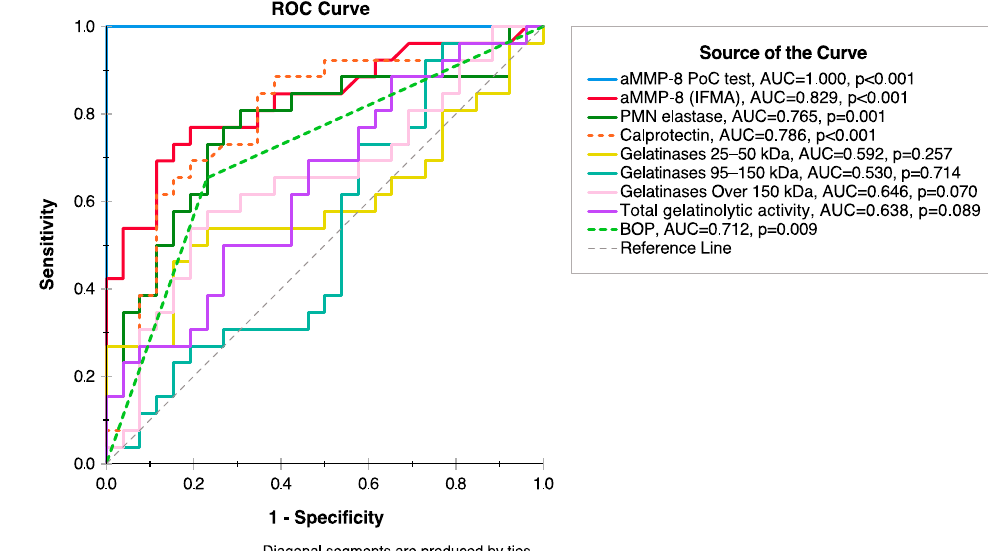
Figure 1. Receiver operating characteristic (ROC) analysis illustrating the diagnostic ability of active matrix metalloproteinase-8 (aMMP-8) chair-side / point-of-care (PoC) test and selected potential biomarkers: polymorphonuclear leukocyte (PMN) / neutrophil elastase, calprotectin, gelatinases (25–50 kDa, 95–150 kDa, over 150 kDa and total gelatinolytic activity) and bleeding on probing (BOP) to discriminate peri-implantitis from healthy dental implant (26 peri-implant and 26 healthy dental implant patients). aMMP-8 PoC test and selected potential biomarkers were assessed as described previously [31]. This figure has been constructed by authors ITR and TS based on the same study group as described in Lähteenmäki et al. and further extends their results [31]. Table 1. Grading of peri-implantitis and periodontitis and the risk of their progression (modified from Tonetti et al. [34] and Sorsa et al. [33]) by active matrix metalloproteinase-8 (aMMP-8) as the main biomarker for active / progressing peri-implant and periodontal diseases. Here, the aMMP-8 cut-o ff s for peri-implantitis and periodontitis are applicable to ImplantSafe ® and PerioSafe ® lateral flow aMMP-8 point-of-care immunotests utilizing the same antibody in the aMMP-8 measurements [25,29,33]. Grading of the Risk of Disease Progression in Peri-Implantitis and Periodontitis by aMMP-8 No or Low Risk Elevated